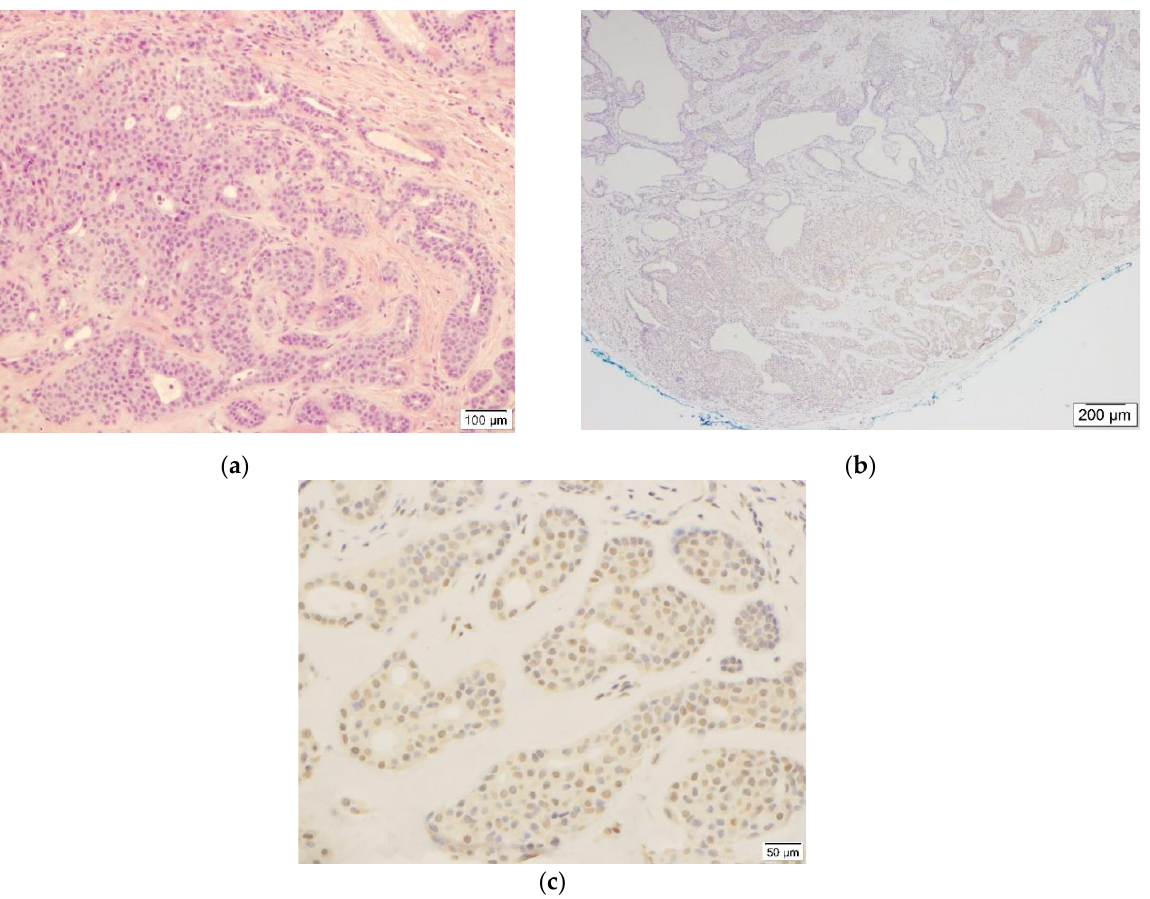
Figure 1. This figure shows benign chondroid syringoma (( a ) , H&E, 10×, case #1) and weak (1+) TFE3 staining (( c ), TFE3, 20×) in less than 20% of tumor cells in the corresponding area (( b ), TFE3,